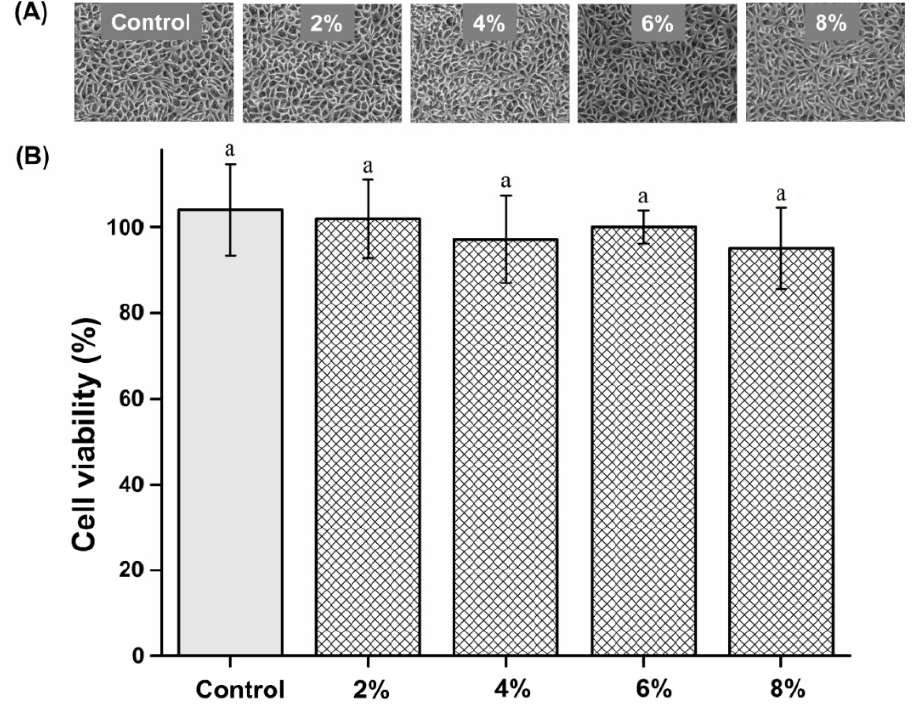
Figure 7. ( A ) Micrographs of L929 cells. ( B ) Comparison of cell viability of the different groups. “a” indicates no statistically significant difference (P > 0.05).